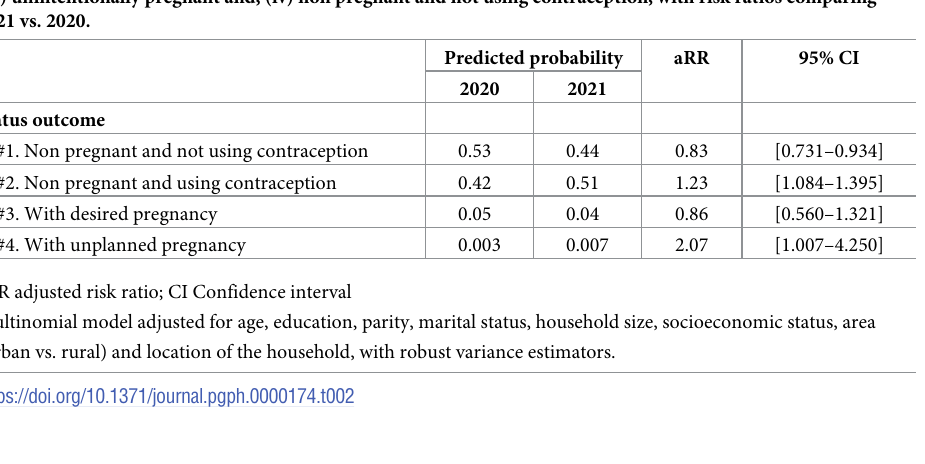
Table 2. Women’s likelihood of being (i) non pregnant and not using contraception; (ii) intentionally pregnant; (iii) unintentionally pregnant and; (iv) non pregnant and not using contraception, with risk ratios comparing